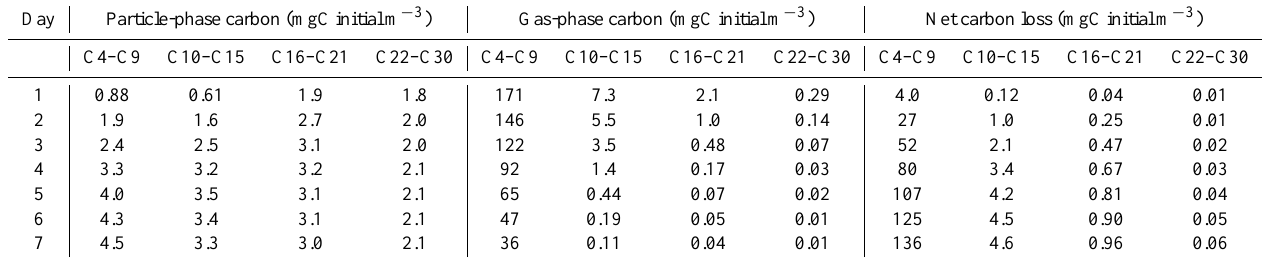
Figure 6. Carbon partitioning budget during the urban outflow simulation. Black lines show the gas (dashed line) and particle (solid line) phases at the start of outflow. Stacked bars show partitioning after 4 days: brown, particle phase; light green, persisting gas phase; white, net loss to fragmentation. Carbon numbers 4 to 9 are plotted twice, on different scales, to allow the details of the partitioning to be seen more clearly. Table 2. Carbon partitioning budget time series for the urban outflow simulation. Values are assessed at midnight on the days indicated. Losses are assessed relative to 16:00. on day 1. Values <100 are rounded to either two significant figures or two decimal places.